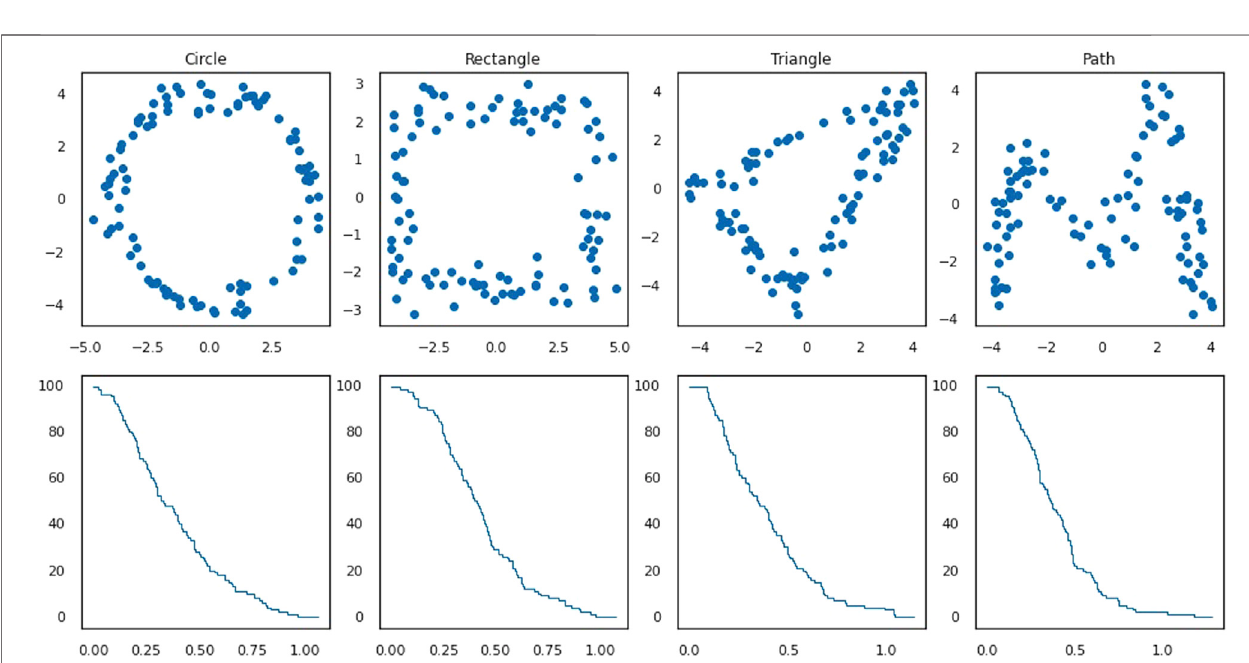
FIGURE 2 | First row: examples of point clouds representing four plane fi gures in the dataset, one for each of the four shapes. Second row: the corresponding standard stable ranks of the persistence modules given by the 0-th homology of the Vietoris-Rips complexes of the plane fi gures.